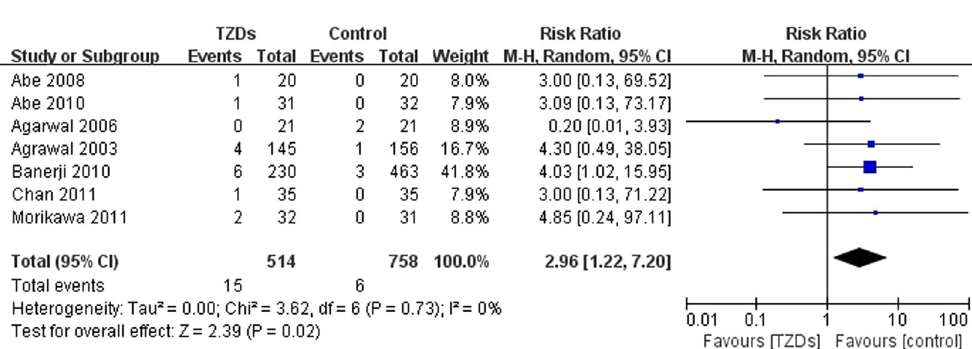
Figure 5. Change in weight among patients with diabetes mellitus and renal impairment receiving TZDs versus control from RCTs.